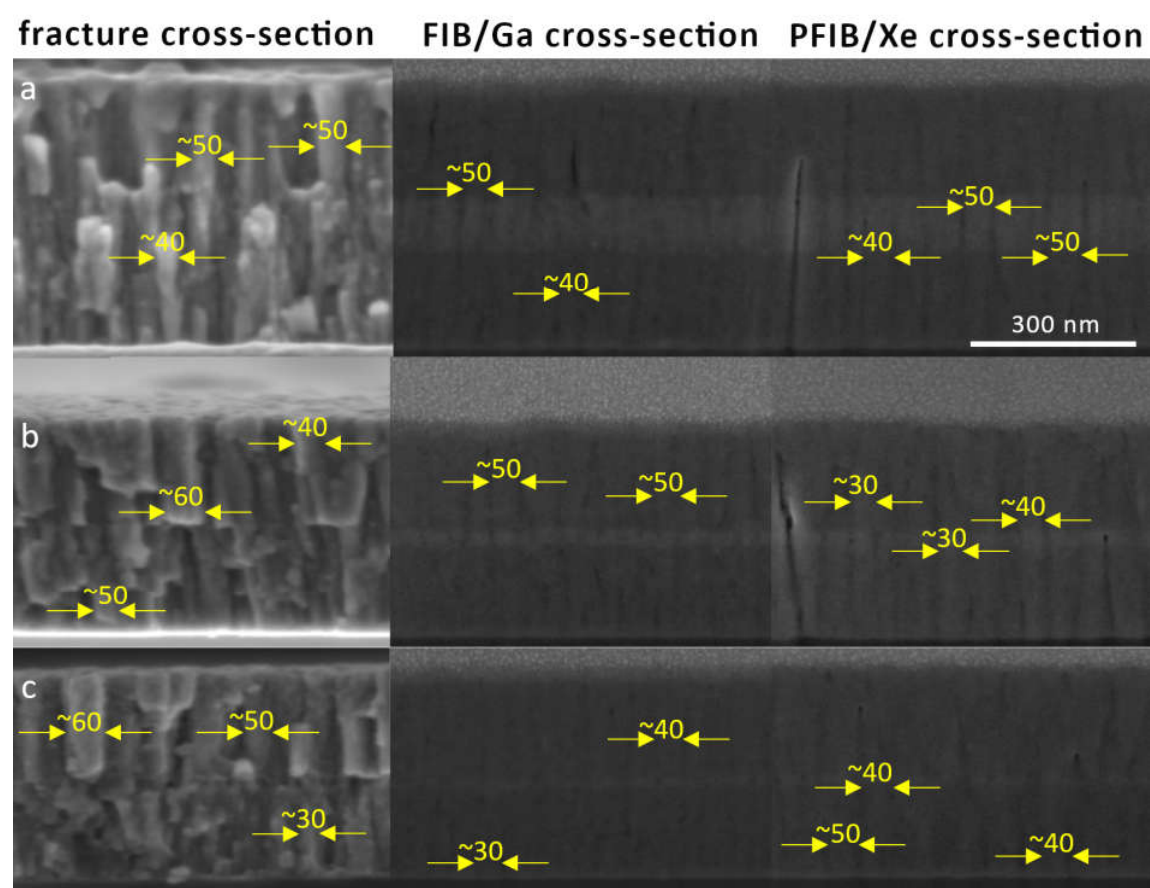
Figure 3. Determination of column width based on cross sections of Ti/V/Ti multilayers (with various thicknesses of the middle V layer: ( a ) 100 nm, ( b ) 30 nm, and ( c ) 10 nm) prepared by fracture technique, FIB/Ga, and PFIB/Xe. Note: The SEM images were recorded at high resolution and their original version can be found in the Supplementary Materials.